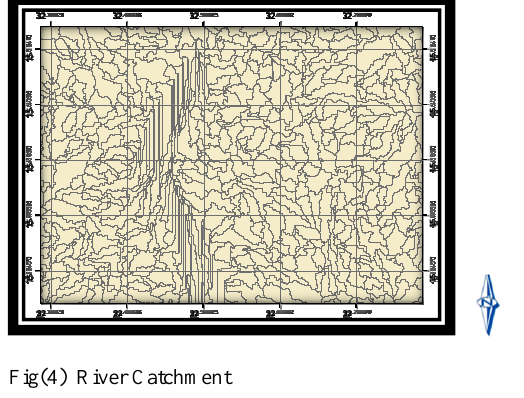
Fig(4) River Catchment